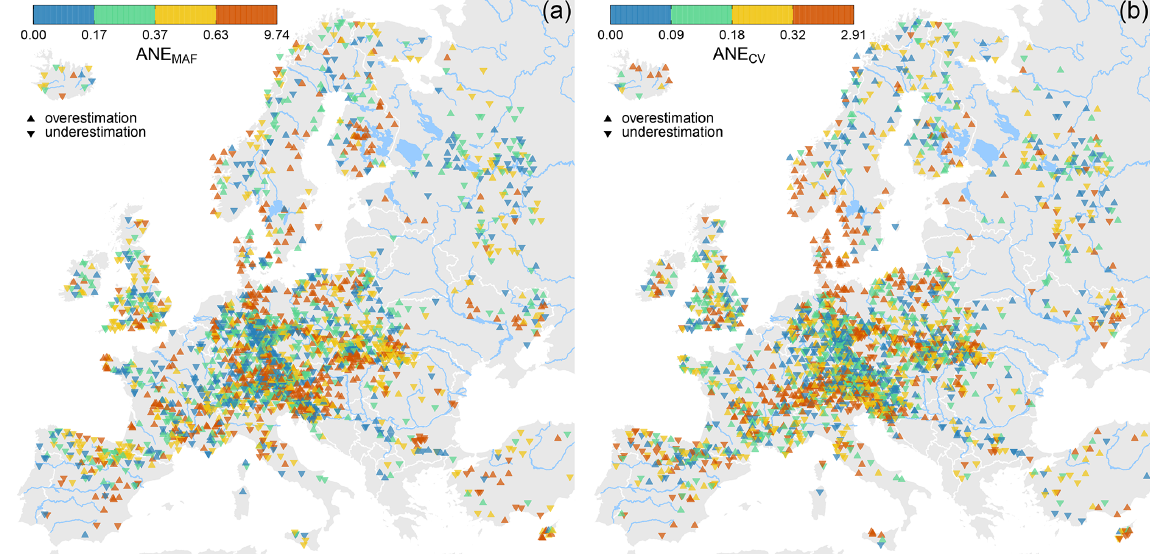
Figure 9. Absolute normalized errors ANE MAF and ANE CV of the predictions of the regional regression models for MAF and CV. Errors are evaluated on the scale of data (not logarithmized). Colours refer to binned classes of equal frequency. Triangles facing upwards indicate gauges, where the model overestimates the moments, triangles facing downwards where the model underestimates.